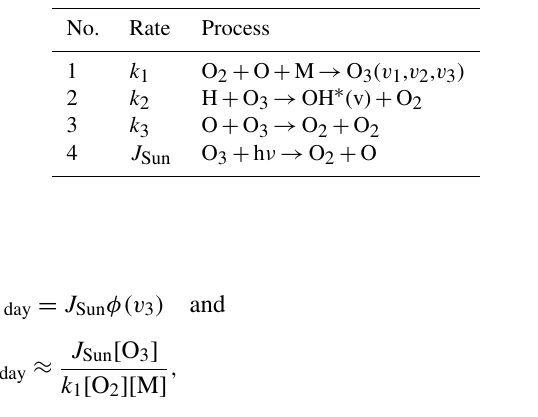
Table 1. Collisional and radiative processes affecting the O 3 vibra- tional levels.